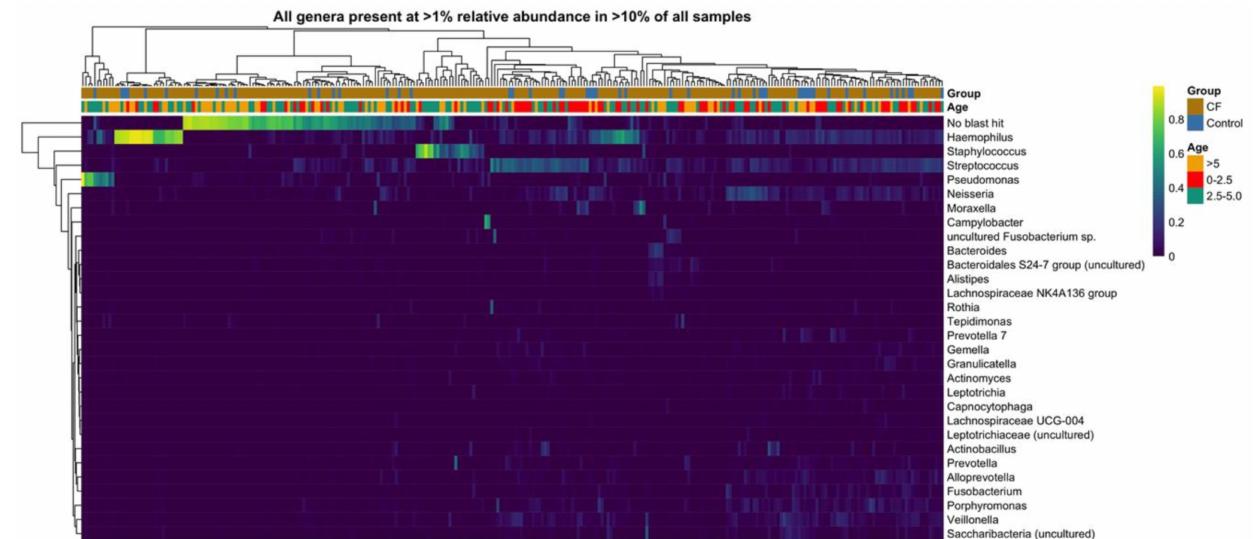
Figure 1. Heatmap of all genera present at ≥ 1% relative abundance in ≥ 10% of all